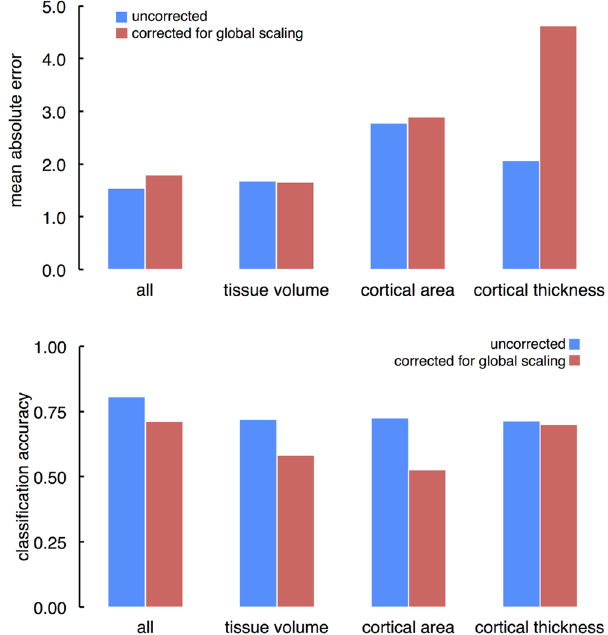
Figure 4. Age and sex prediction after correction for global scaling. (Top) Mean absolute error for the full manifold and for each imaging metric are shown before and after correction for individual differences in global scale. (Bottom) Corresponding sex classification accuracies for the full manifold and for each imaging